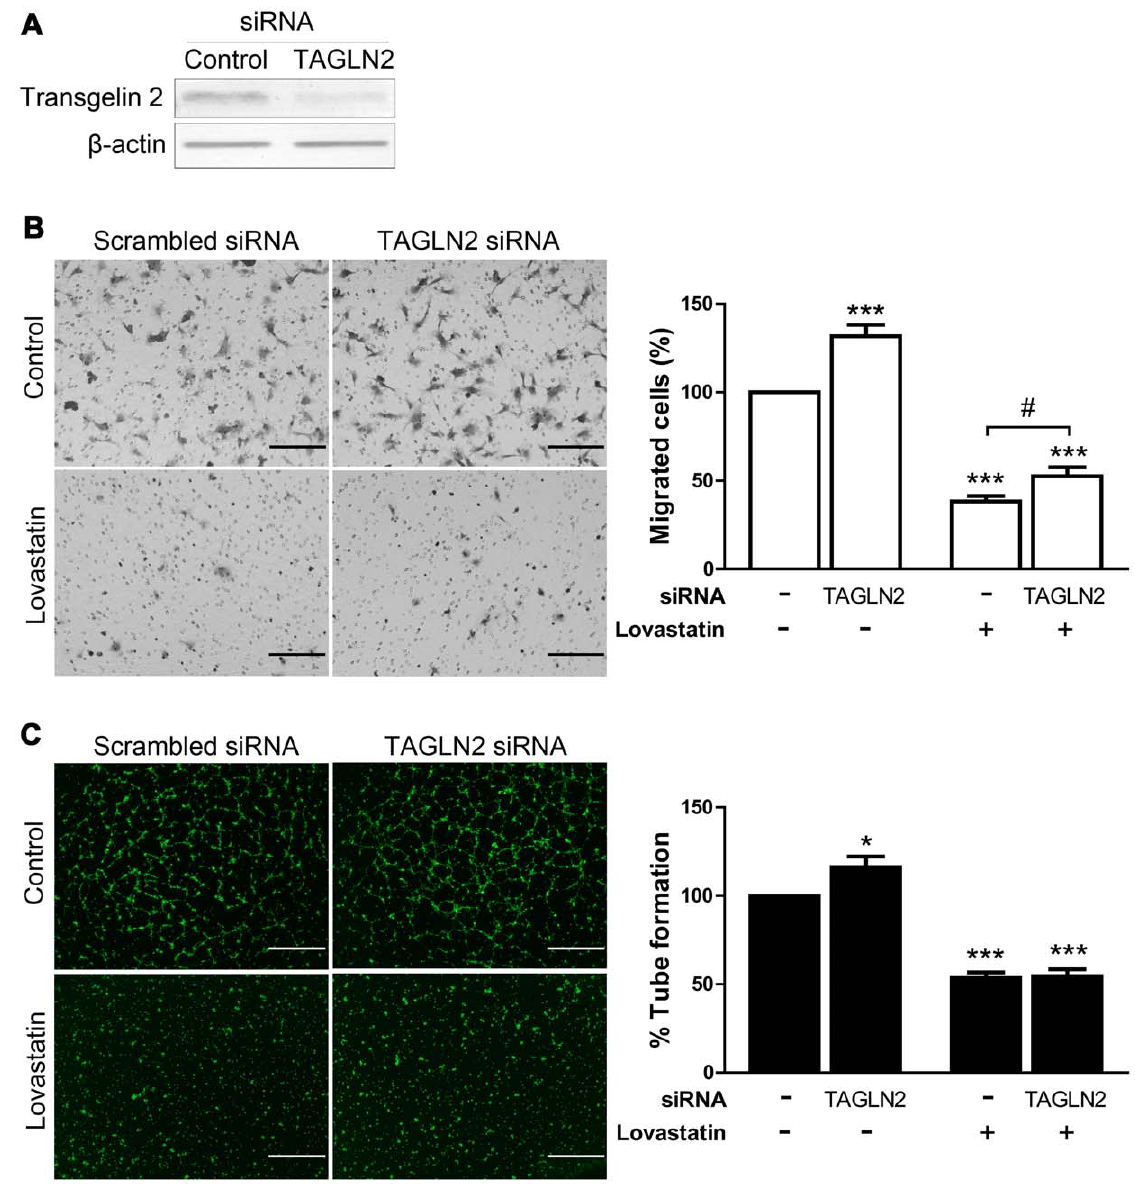
Figure 4. Effects of transgelin 2 knock-down on HUVECs migration and tube formation. (A) Immunoblotting verified the degree of transgelin 2 (TAGLN2) depletion by siRNA. b -actin was employed as loading control. (B) After 24 h of siRNA transfection, cells were treated with lovastatin (10 m M) or vehicle for another 24 h and analyzed for cell migration (scale bar: 200 m m, 6 20 objective). Data are evaluated for the average number of migrated cells relative to basal conditions with control siRNA-transfection (n=6). (C) Cells treated as in (B) were analyzed for tube formation (scale bar: 1 mm, 6 4 objective). Data are evaluated for the area covered by tubes relative to basal conditions with control siRNA- transfection (n=5). Data represent mean 6 SEM. *, p , 0.05; ***, p , 0.001 versus control siRNA-transfected untreated cells. # , p ,